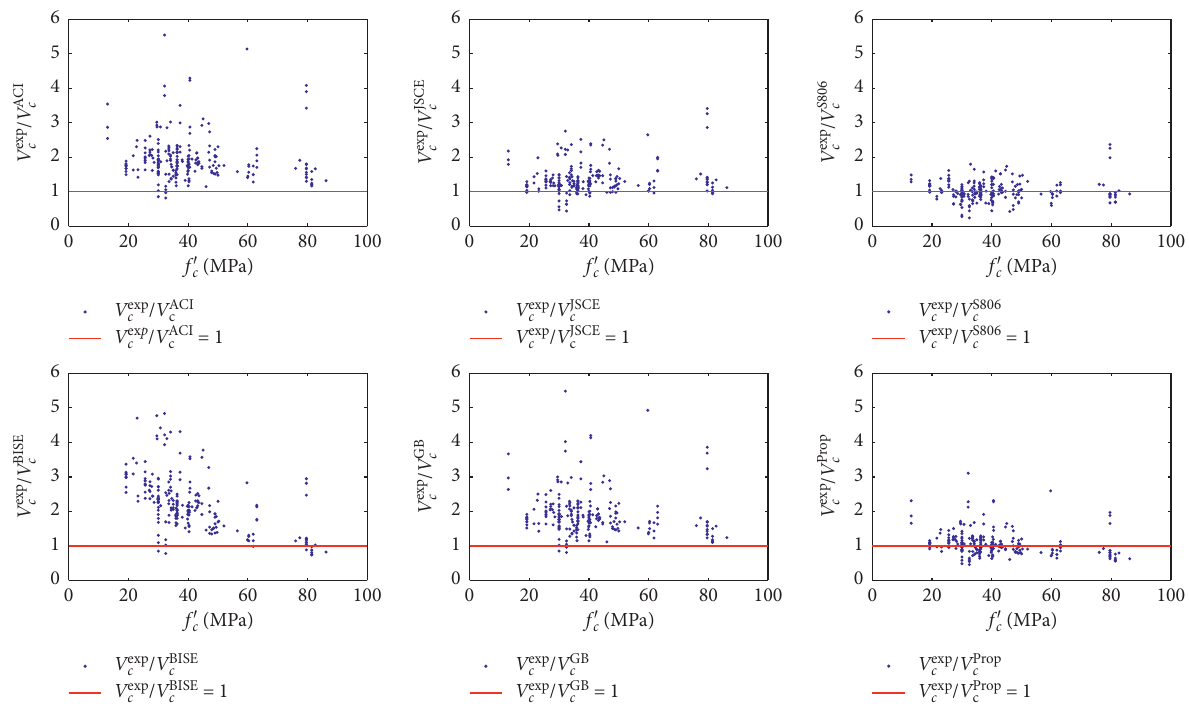
V pred ) with the change of f c / c